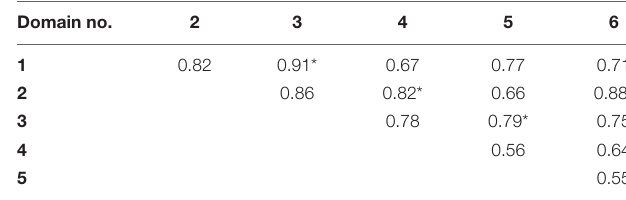
TABLE 2 | Correlation matrix (Pearson’s r) between PP in the six subdomains and for the period 2003–2013 ( n = 294–327, all are significant). Domain